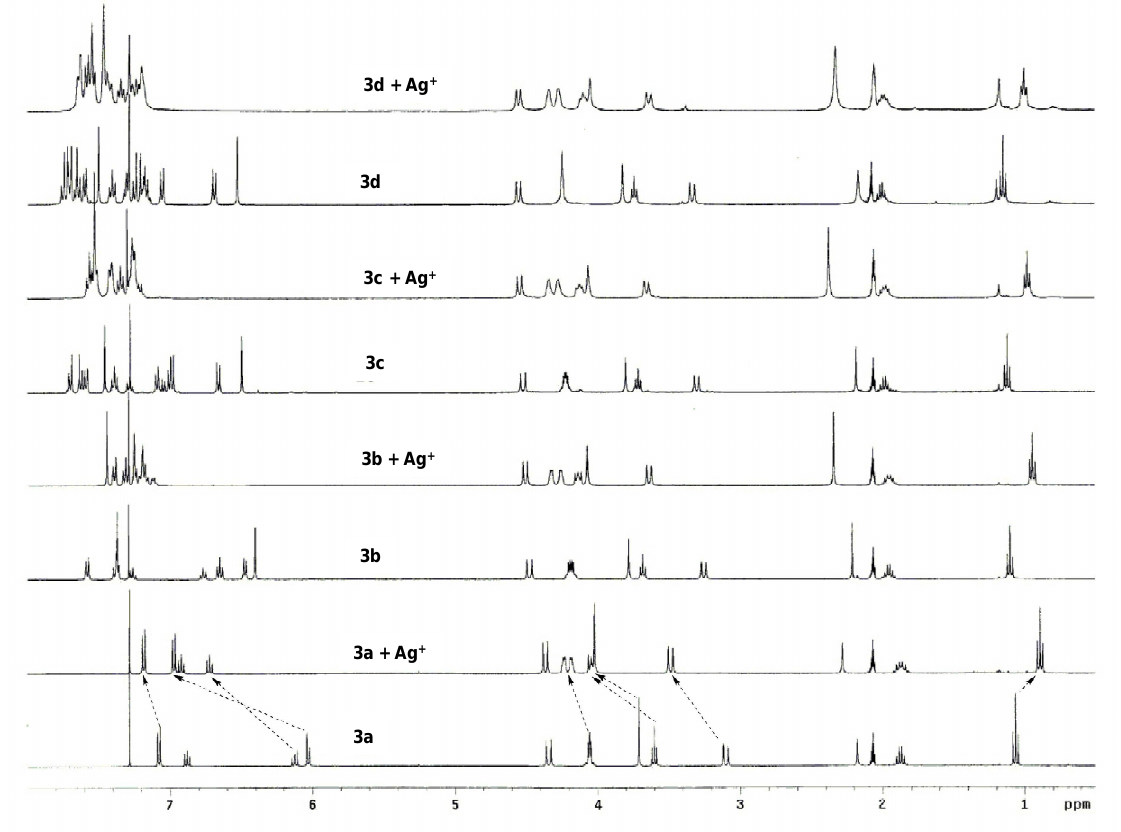
Figure 6. 1 H-NMR spectra of calix[4]crown-4s, 3a-d and the corresponding spectra